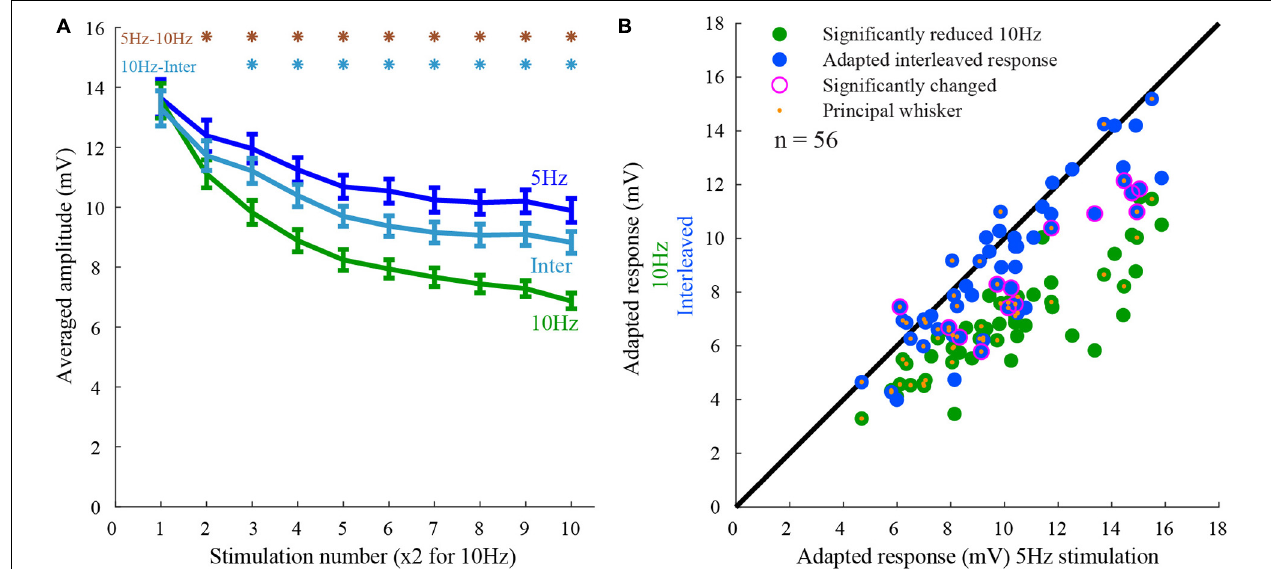
FIGURE 2 | Population response to 5 Hz, 10 Hz, and interleaved stimulation. (A) The peak amplitude of the responses to the three stimulation conditions (5Hz, 10Hz, and interleaved). Note that cells exhibited adaptation from the second stimulus onward. The degree of adaptation during the interleaved stimulation was closer to that for 5 Hz stimulation than for the 10 Hz. The responses to 10 Hz stimulation were significantly different from the others, as marked by the asterisks (rank-sum, p < 0.05). (B) Responses of layer 2/3 cells (each point represents a single whisker test) to whisker deflection at 10 Hz and interleaved stimulation protocols are compared to that obtained by 5 Hz stimulation. The adapted-state response to stimulation of each whisker obtained by the control stimulation pattern (5 Hz) was on average larger than the response to 10 Hz stimulation (green) and interleaved stimulation (blue). Large magenta circles indicate a significant difference from the response to 5 Hz stimulation. Orange dots mark the principal